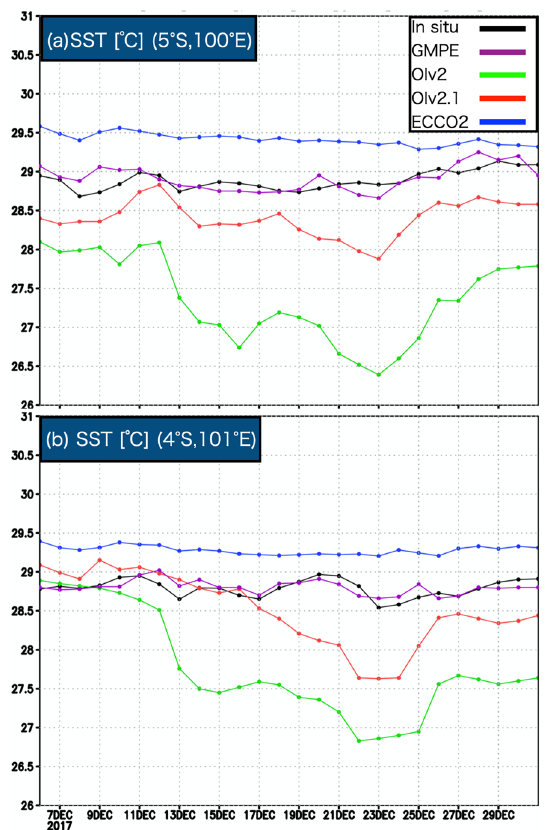
Figure 3. Daily SST variations obtained with respect to ( a ) the Sumatra buoy [5° S, 100° E] and ( b ) R/V Mirai CTD data [4° S, 101° E] (black) from GMPE (purple), OIv2 (green), OIv2.1 (red), and ECCO2 SST